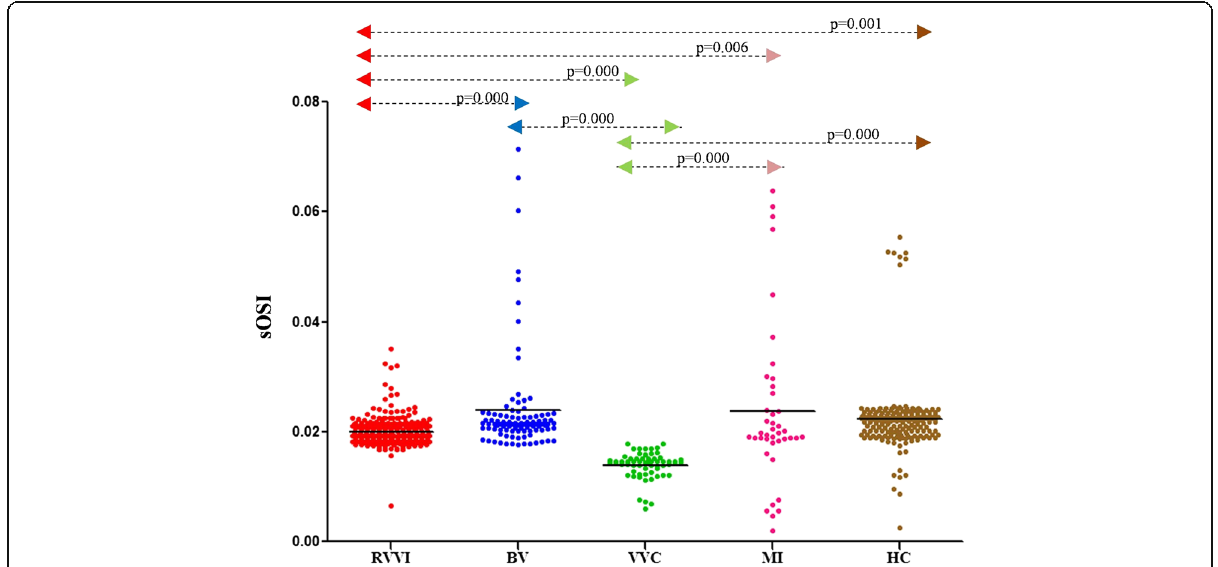
Fig. 3 sOSI in different clinical categories of RVVI and healthy controls (HC). Dot plot presenting the distribution of sOSI levels in patients and controls. Horizontal line signifies the mean